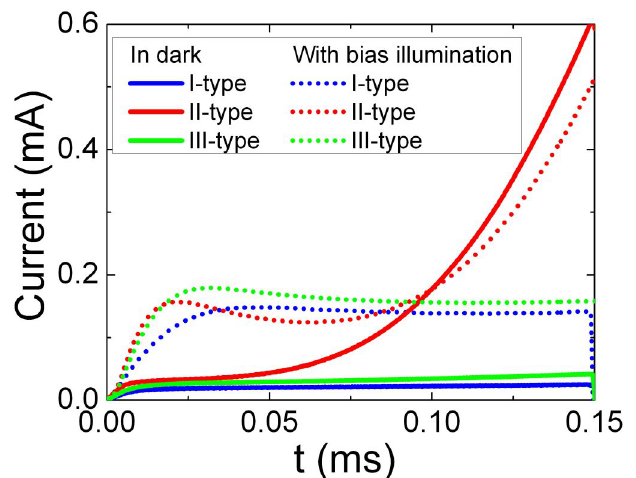
Figure 1. The typical barrier evaluation by linearly increasing voltage (BELIV) transients observed in structures of a different type Cu S-CdS junction without (solid curves) and 2 with steady-state wide spectral band illumination (dot curves) by applying the linearly increasing voltage pulse with 1.2 V amplitude at reverse